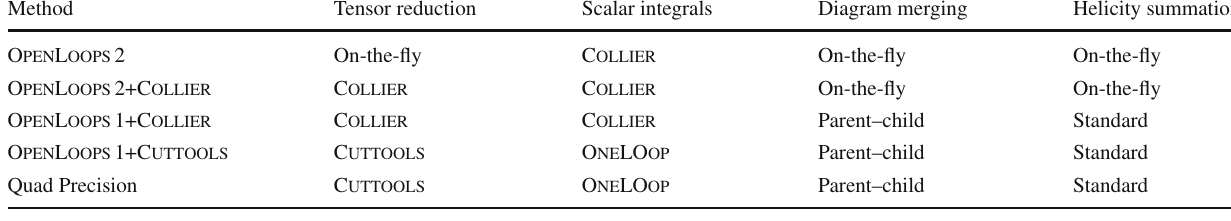
Fig. 13 Runtimes per phase space point for the calculation of the one-loop scattering probability (1) on a single Intel i7-4790K core with gfortran-4.8.5. Results for the processes in (153) are plotted versus the number of one-loop diagrams. Timings of OpenLoops2 with on-the-fly reduction ( t OL2 ) are shown on-the-fly in the upper frame. The lower frame presents a comparison to OpenLoops2+Collier and